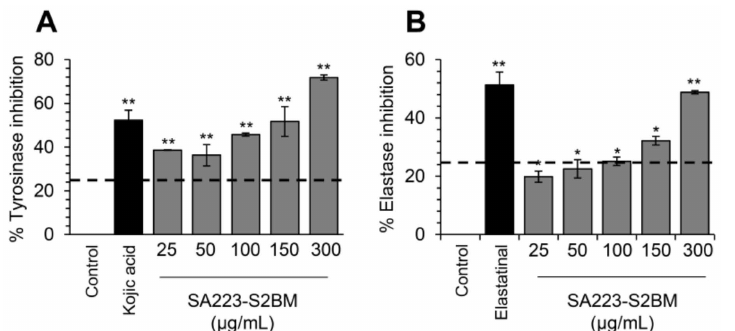
Figure 5. Anti-melanogenic and anti-elastase properties of the SA223-S2BM extract. ( A ) In vitro determination of tyrosinase inhibition activity (%) by the SA223-S2BM extract at the indicated concentrations. ( B ) In vitro evaluation of elastase inhibition activity (%) by the extract at the shown concentrations. In ( A ), Kojic acid (2 µ g/mL) was used as a positive control. In ( B ), elastatinal (0.5 µ g/mL) was used as a positive control. Bars, ± SD ( n ≥ 2); * p < 0.05; ** p <